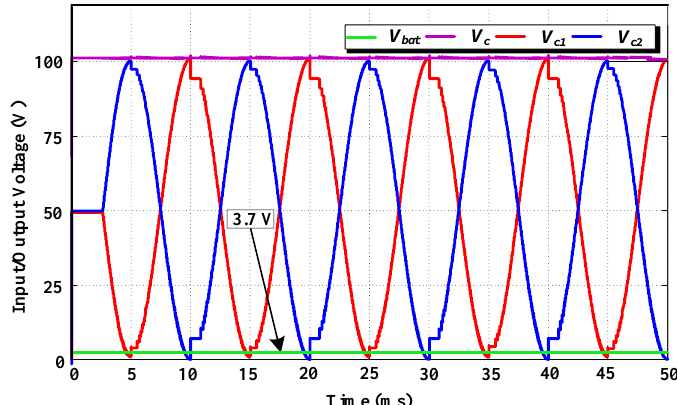
Figure 10. Simulation waveforms of the drive stage.